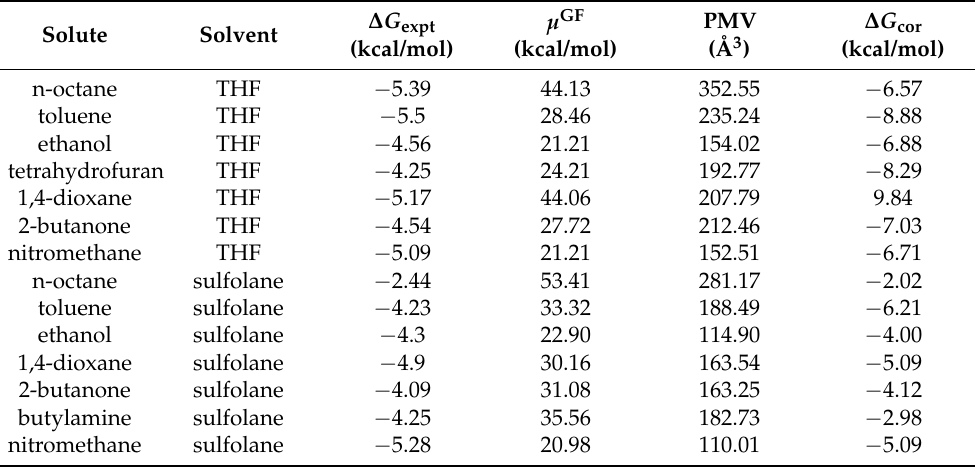
Table 3. Experimental SFEs ( ∆ G expt ), 3D-RISM-KH computed excess chemical potential ( µ GF ), partial molar volume (PMV), and corrected SFEs ( ∆ G cor